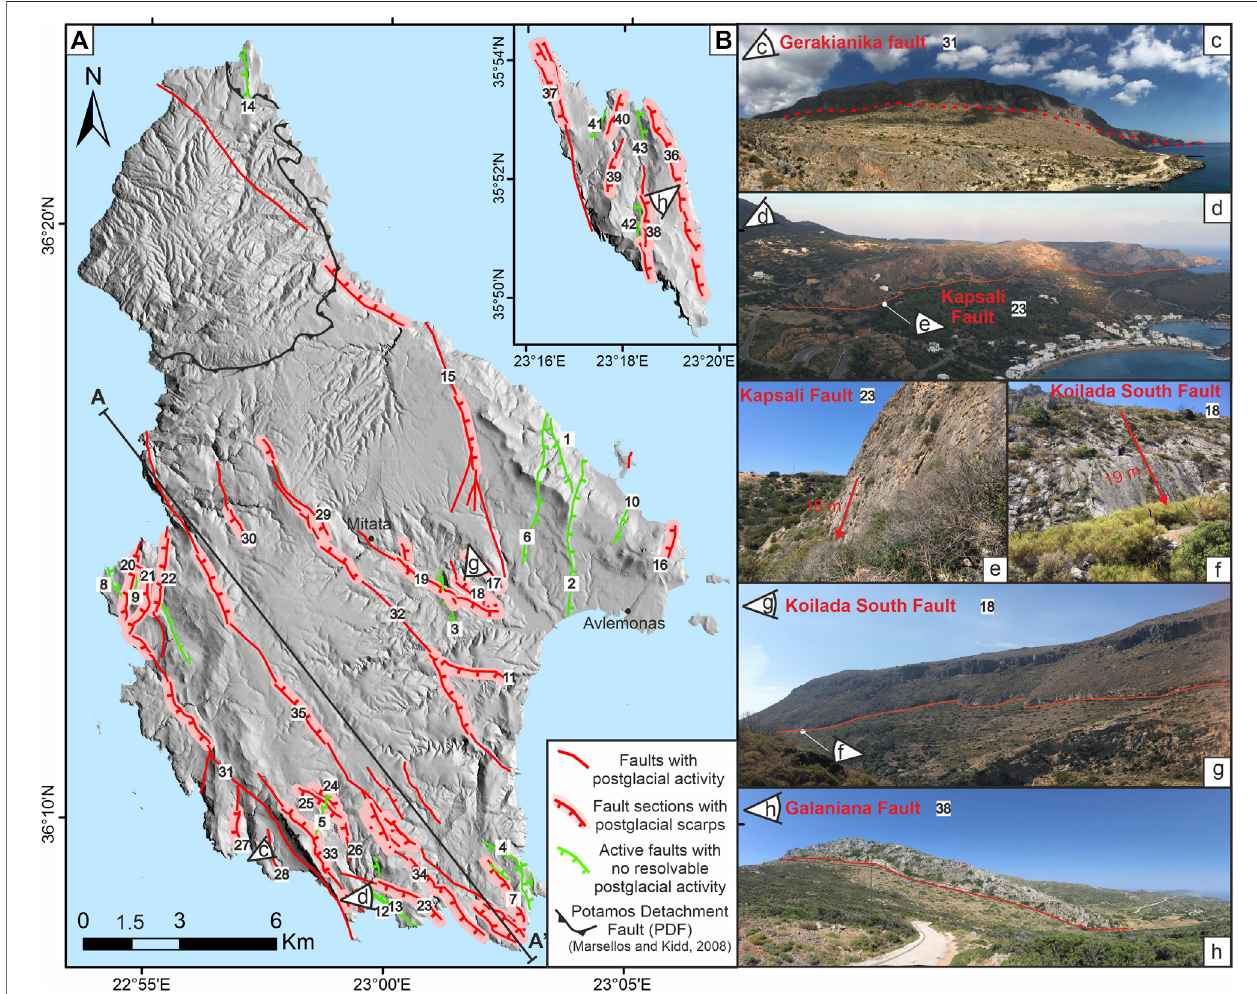
FIGURE2| FaultmapofKythira (A) andAntikythira (B) .Linesontheshadedreliefmapindicateactivenormalfaultswithresolvableactivityduringthelast ∼ 16 years (postglacial scarps are also highlighted in pink) and late-Quaternary activity alone (with no resolvable postglacial displacement). Numbers next to faults correspond to faultID ’ sin Tables1 , 2 .Eye-shapedsymbolsindicatethelocalitiesonKythiraandAntikythirawhereeachofthephotosillustratedwastaken(c,d,e,f,g,andh).Thesolid black line indicates the location of the Pro fi le A-A ′ presented in Figures 10A , B .